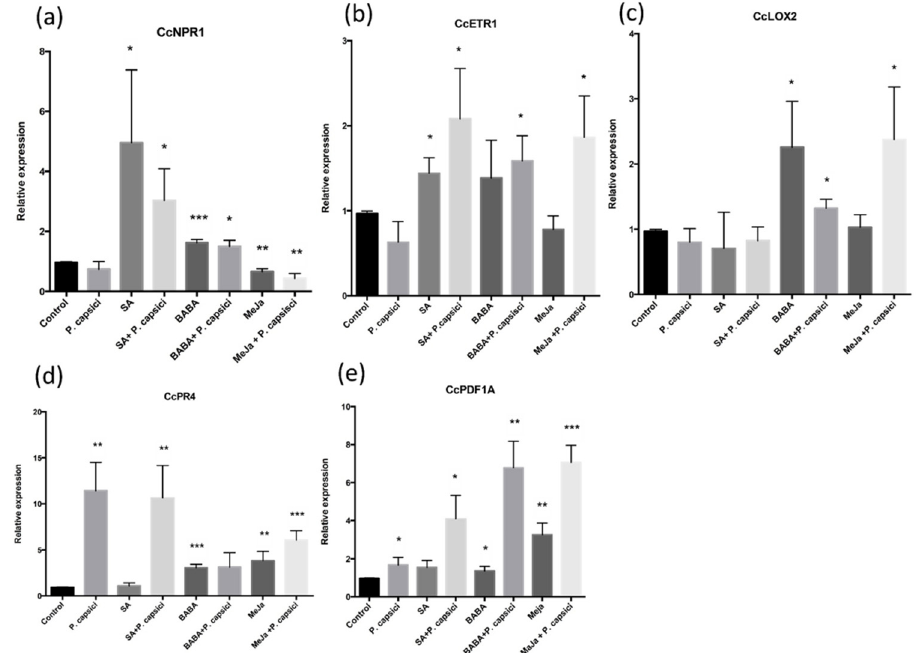
Figure 4. Relative expression of the genes stress-responsive in plants of C. chinense when are applied an elicitors treatment and challenged with P. capsici : CcNPR1 ( a ), CcETR1 ( b ), CcLOX2 ( c ), CcPR4 ( d ), and CcPDF1 ( e ). The data represented means of triplicate biological and experimental repeats; error bars represented SEM. The asterisk indicates statistically significant differences between treatments (range test p < 0.05).